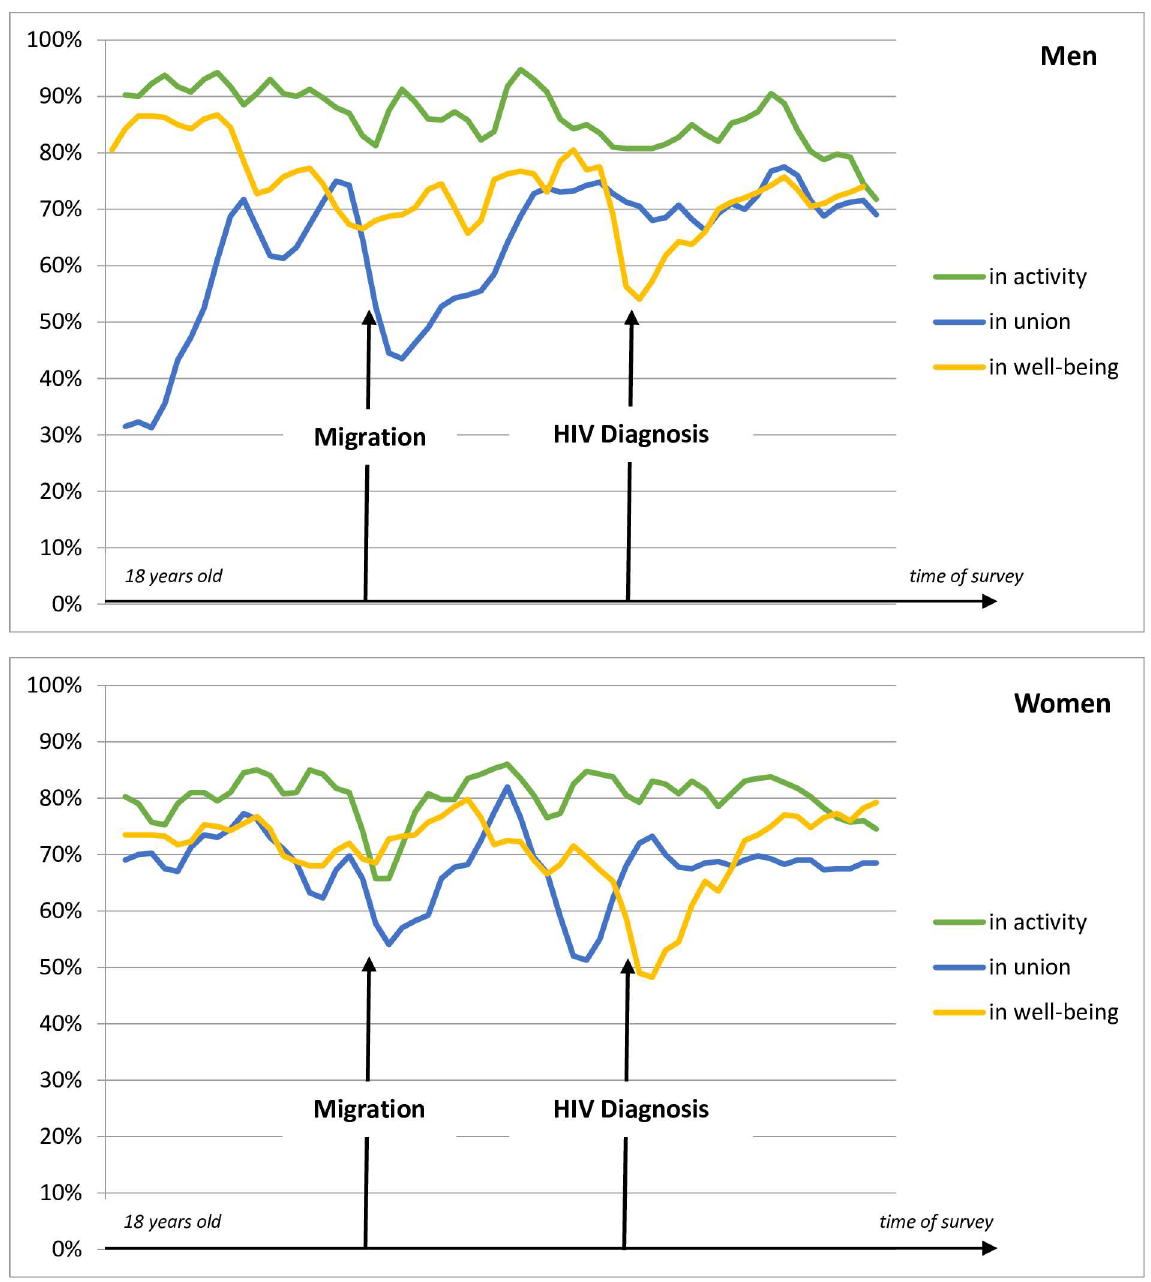
Fig 1. Persons living with HIV: proportion of men and women in activity, union and well-being in relation to migration and HIV diagnosis. Time-relative graphs Scope: men (N = 142) and women (N = 229) from HIV group who have not yet migratedor being diagnosedat 18 years of age, who are observedat least five years after diagnosis, who were diagnosedin France at least one year after arrival. Note: These curves show the proportionof personsin activity, in union and their perceivedwell-beingin relationto two key moments: migrationand diagnosis, for personswho were diagnosed after migration.For more details, please see S2 File and Brou et al. (2007). Source: ANRS ParcoursSurvey